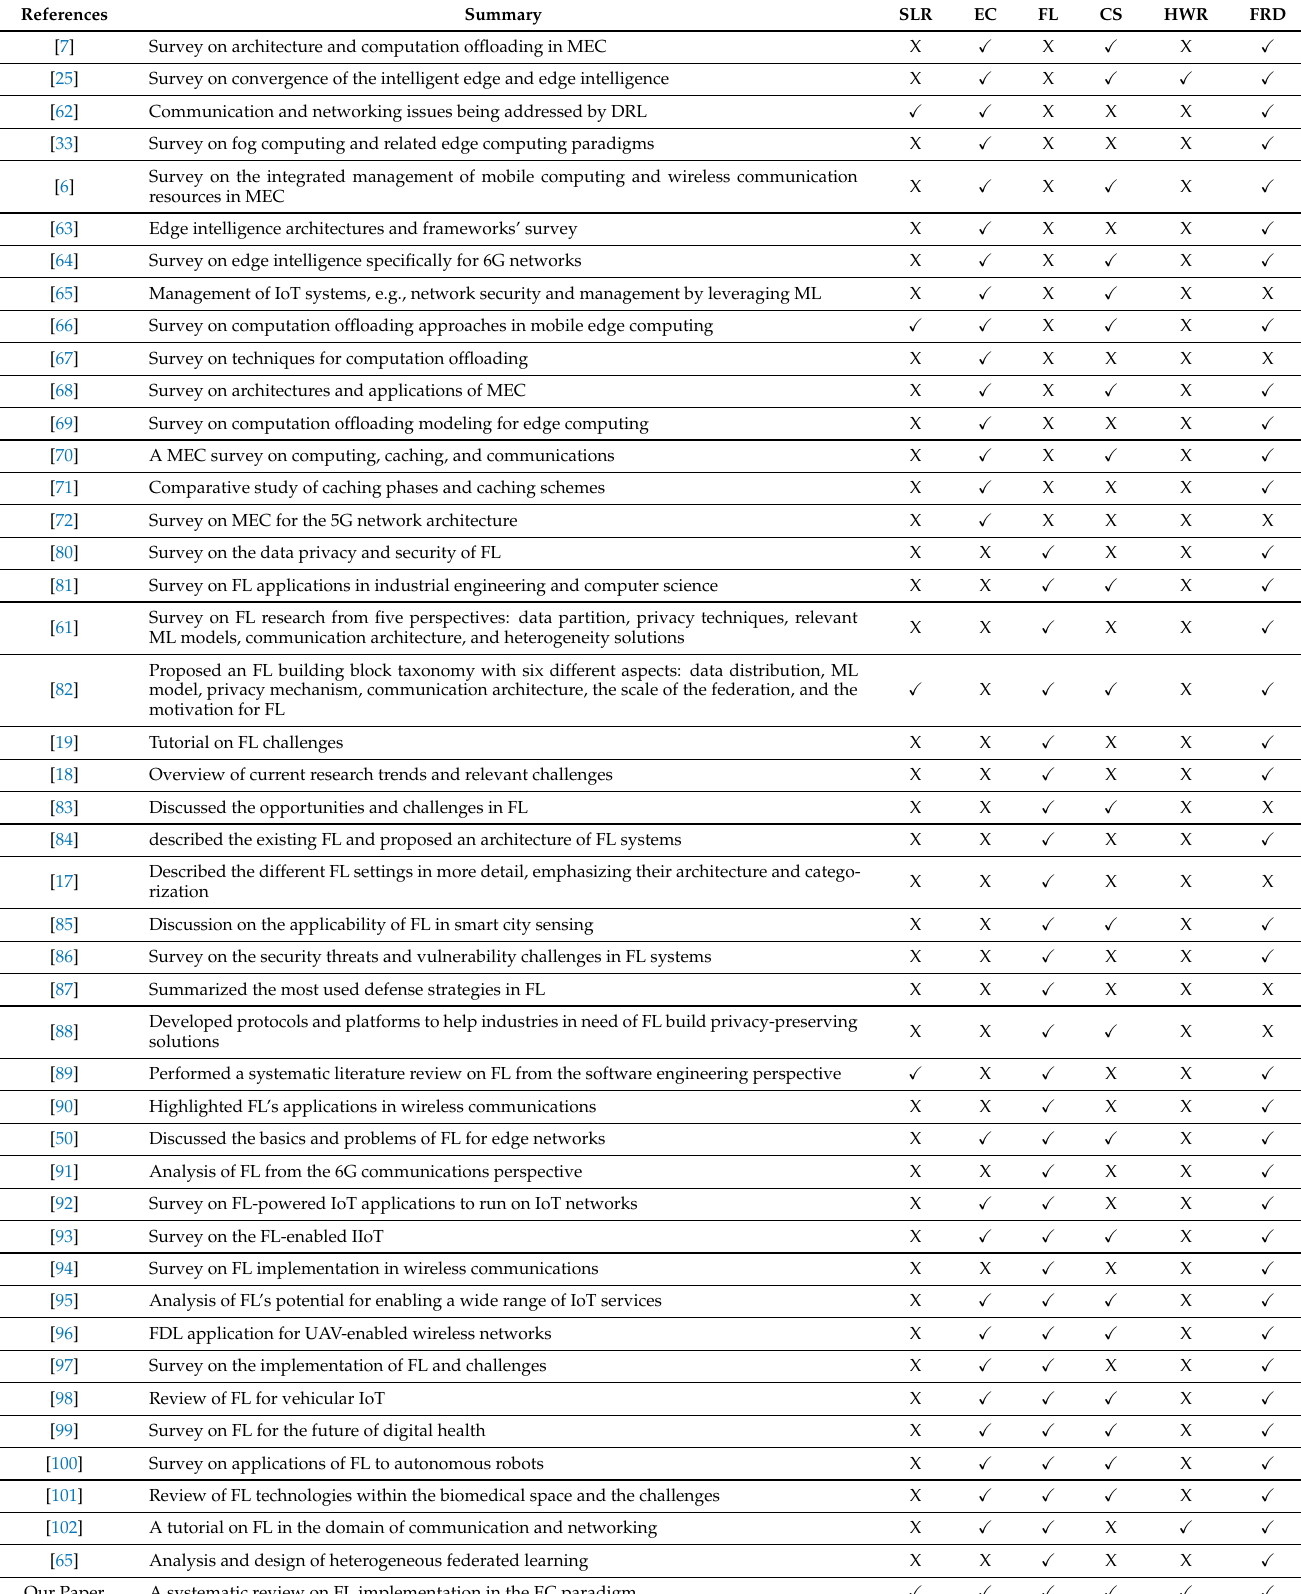
Table 2. Comparison of our survey to current state-of-the-art